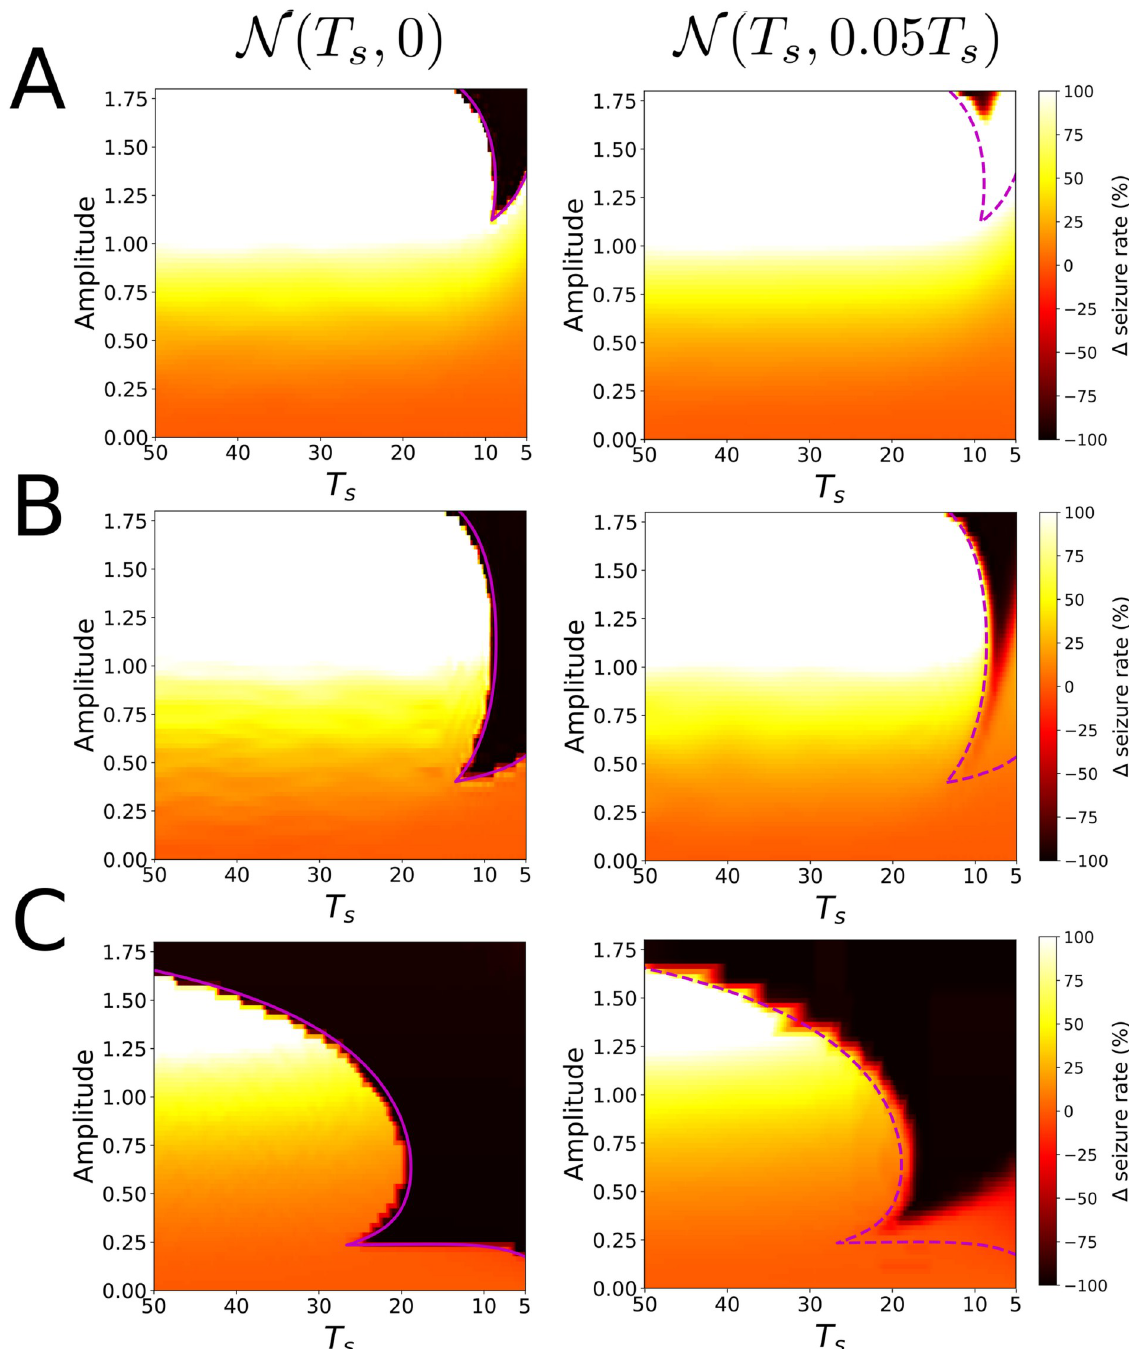
Fig 10. Response of perturbations for the reduced epileptor (29). We show the change in the seizure rate Δ for a random train of pulses whose mean inter impulse interval follows a normal distribution N ð T ; s 2 Þ with a mean time T and standard deviation σ . Panels A, B, C s s ; P and P in Table 1. Left Figures correspond to the periodic case N ð T ; 0 Þ and right Figures to the correspond to the sets of parameters P þ 0 (cid:0) s random case N ð T ; 0 : 05 T Þ . Consistently with our theoretical analysis there is a direct correspondence between the mean distance between s s the lower branch and the slow nullcline and the minimal pulse amplitude A for which perturbations may lead to lock the system. Purple solid lines, bounding locking regimes, correspond to the bifurcations of the map (25). By drawing the same curve for the random case, we illustrate the resilience of locking states to noise. For the specific details about the numerical computation of this Figure, we refer the reader to Materials and Methods